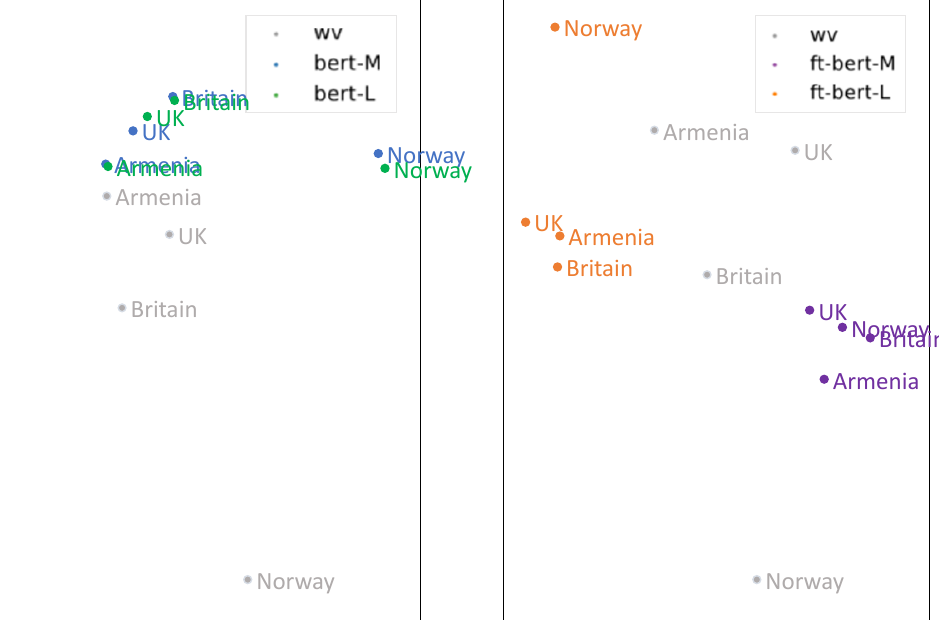
Figure 5. Semantic distribution maps of BERT before ( left ) and after fine-tuning ( right ). “WV” refers to the original semantics of entities, “bert-M” refers to the semantic representation of metonymic entities in BERT before fine-tuning, “bert-L” refers to the semantic representation of literal entities in BERT before fine-tuning, “ft-bert-M” refers to the semantic representation of metonymy entities in BERT after fine-tuning, “Ft-bert-l” refers to the semantic representation of literal entities in BERT after